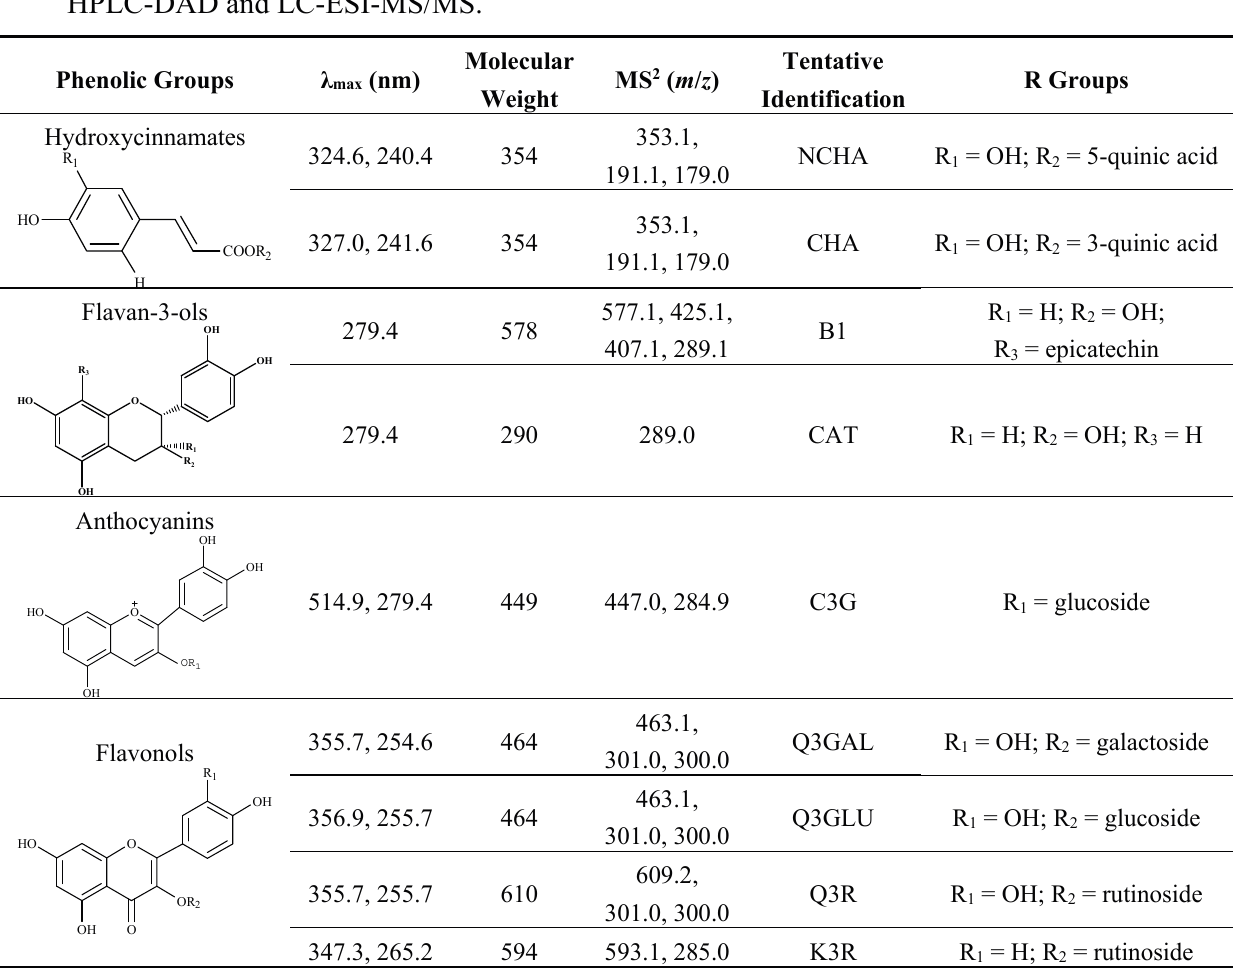
Table 2. Identification of phenolic compounds in peach fruits in negative ions with HPLC-DAD and